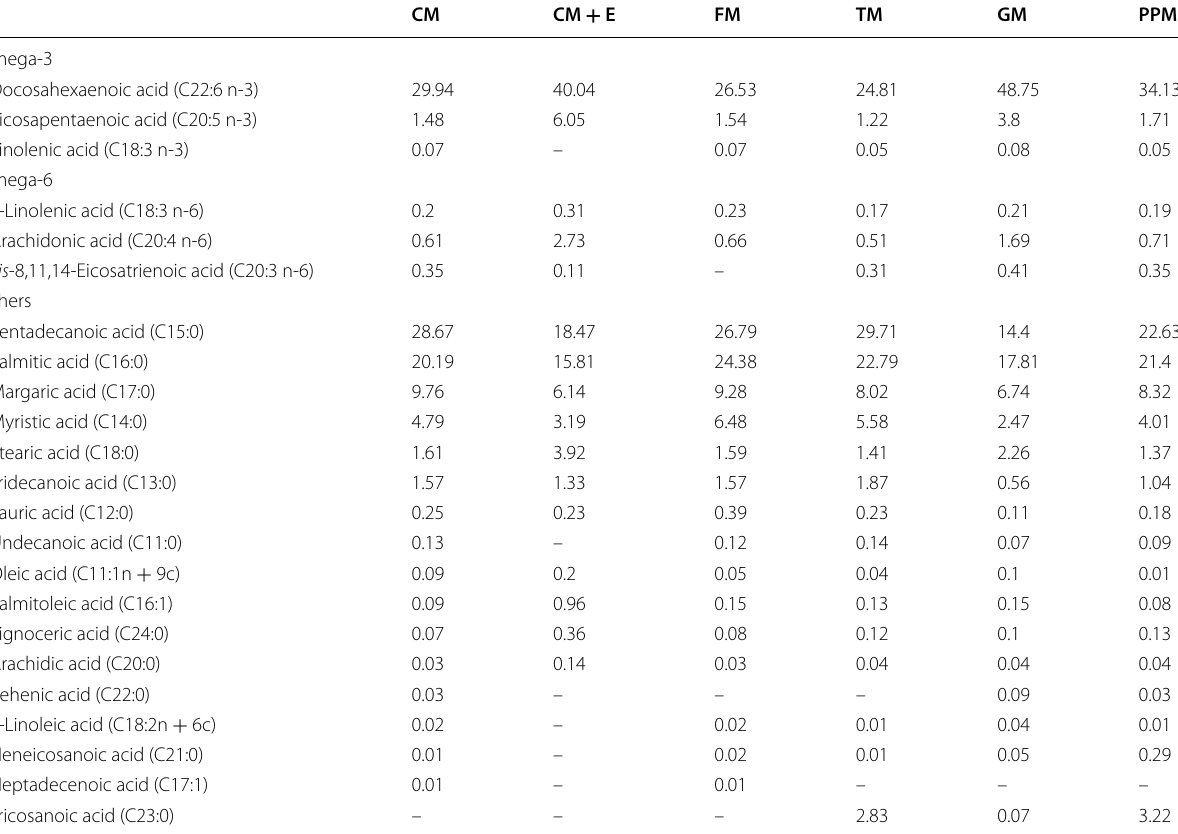
Table 1 Fatty acid compositions (%:w/v) according to Gas chromatography-FID analysis of obtained total fatty acids (Additional file